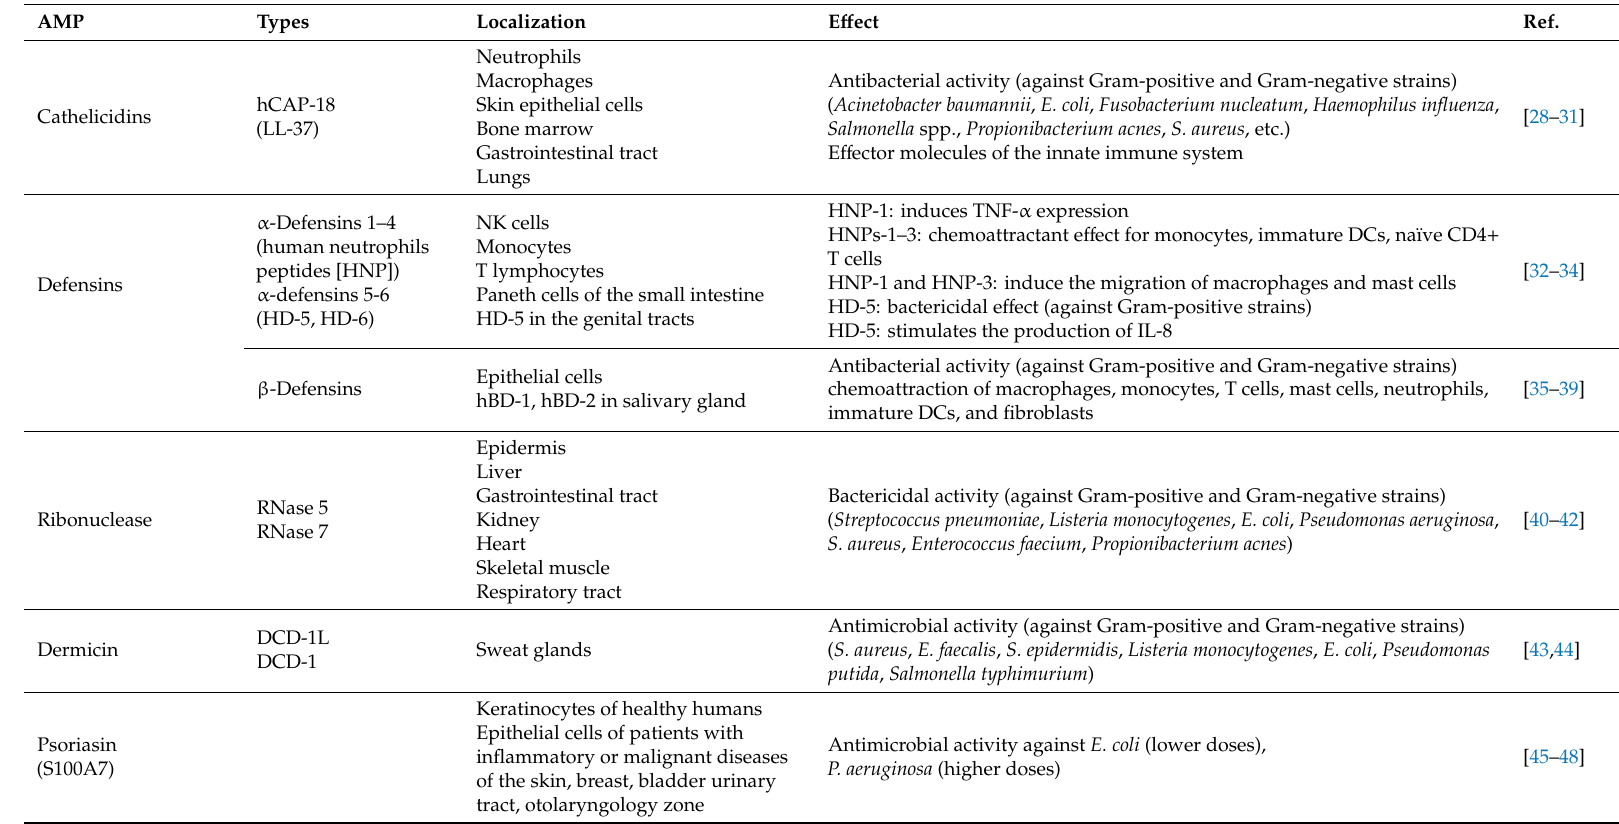
Table 1. Link between antimicrobial peptides and e ff ects on